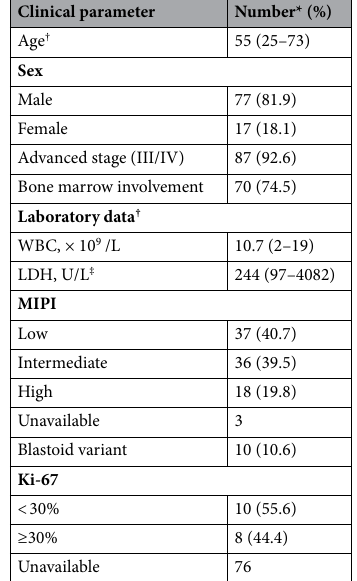
Table 1. Clinical and laboratory features of 94 mantle cell lymphoma patients who received autologous stem cell transplant. MIPI mantle cell lymphoma international prognostic index, WBC white blood cell. *Eight patients received allogeneic stem cell transplant due to relapse/progression of disease after autologous stem cell transplant. † Median (range). ‡ LDH, normal range was 140–271 U/L.